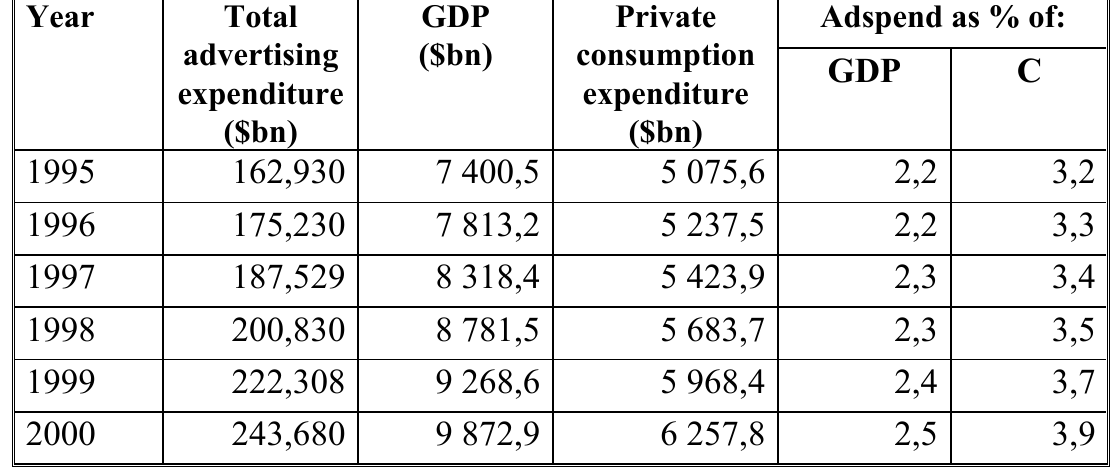
Adspend as % of: Year Total